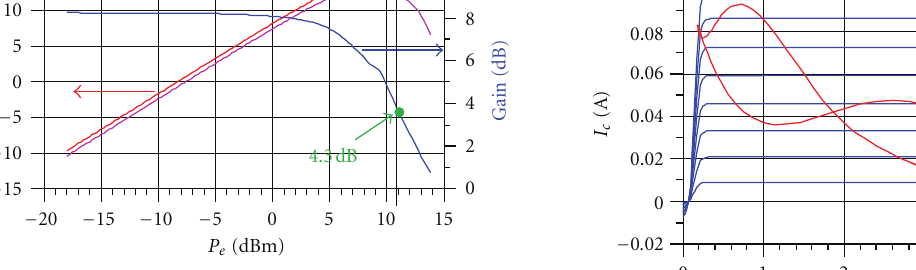
Figure 12: Amplifier simulation results.